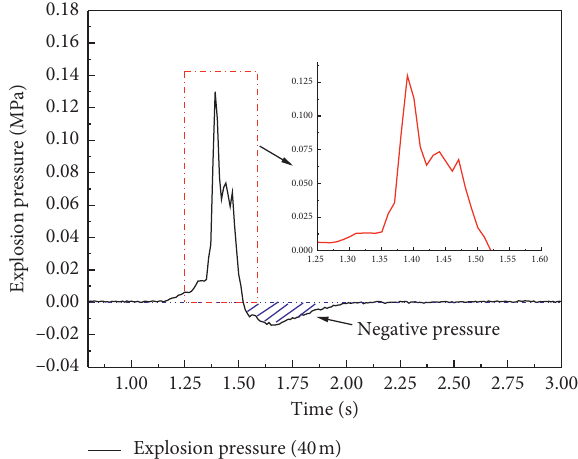
Figure 8: The explosion pressure-time curve at 40m from the point of ignition.